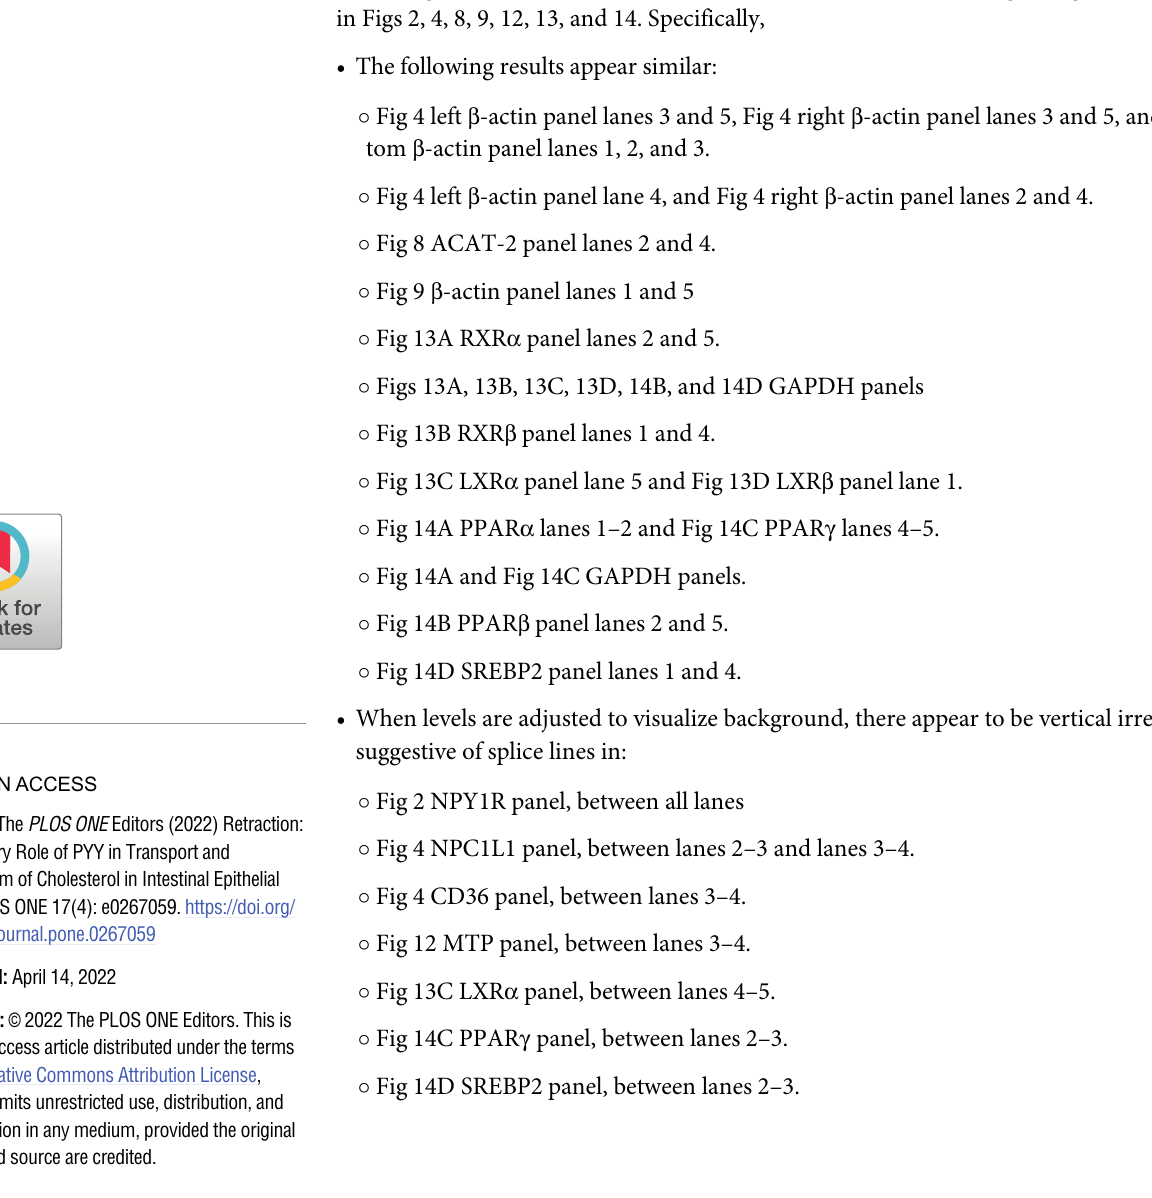
� Fig 4 left β -actin panel lane 4, and Fig 4 right β -actin panel lanes 2 and 4. � Fig 8 ACAT-2 panel lanes 2 and 4. � Fig 9 β -actin panel lanes 1 and 5 � Fig 13A RXR α panel lanes 2 and 5. � Figs 13A, 13B, 13C, 13D, 14B, and 14D GAPDH panels � Fig 13B RXR β panel lanes 1 and 4. � Fig 13C LXR α panel lane 5 and Fig 13D LXR β panel lane 1. � Fig 14A PPAR α lanes 1–2 and Fig 14C PPAR γ lanes 4–5. � Fig 14A and Fig 14C GAPDH panels. � Fig 14B PPAR β panel lanes 2 and 5. � Fig 14D SREBP2 panel lanes 1 and 4.